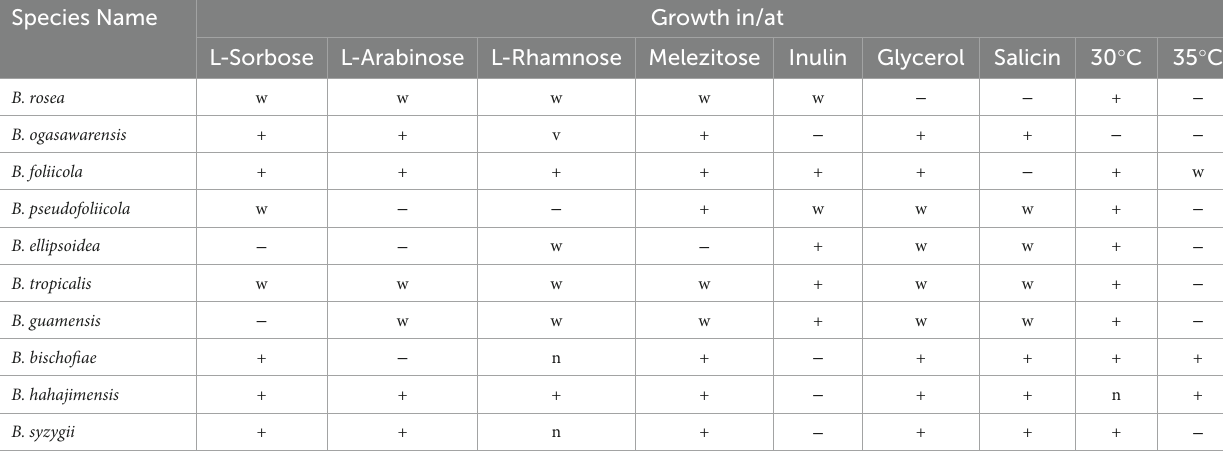
TABLE 4 The main characteristics of species assigned to the genus Bannoa